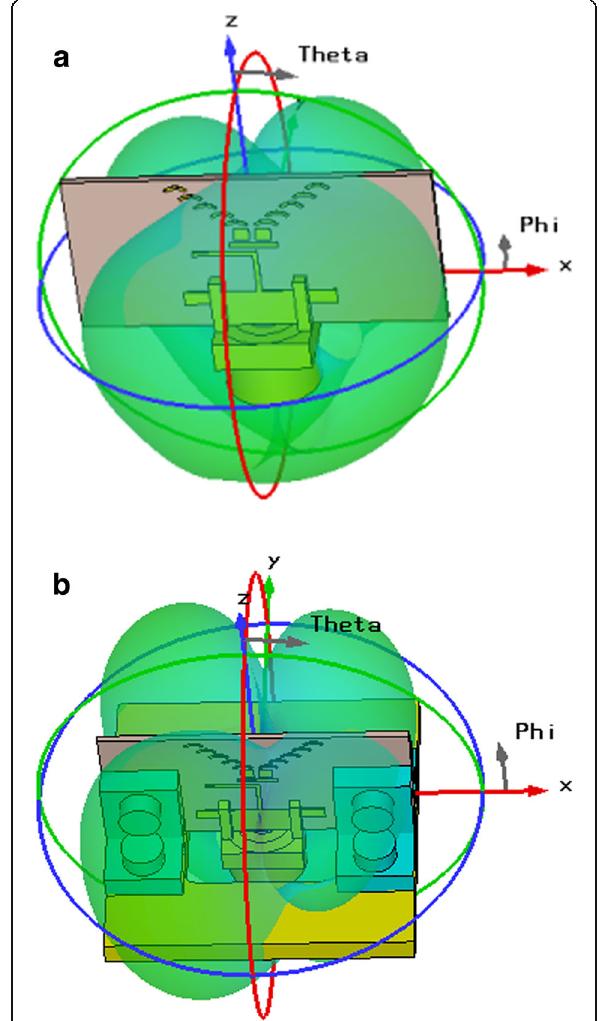
Fig. 16 3D co-polar radiation pattern of the antenna. a Without backplate. b With backplate